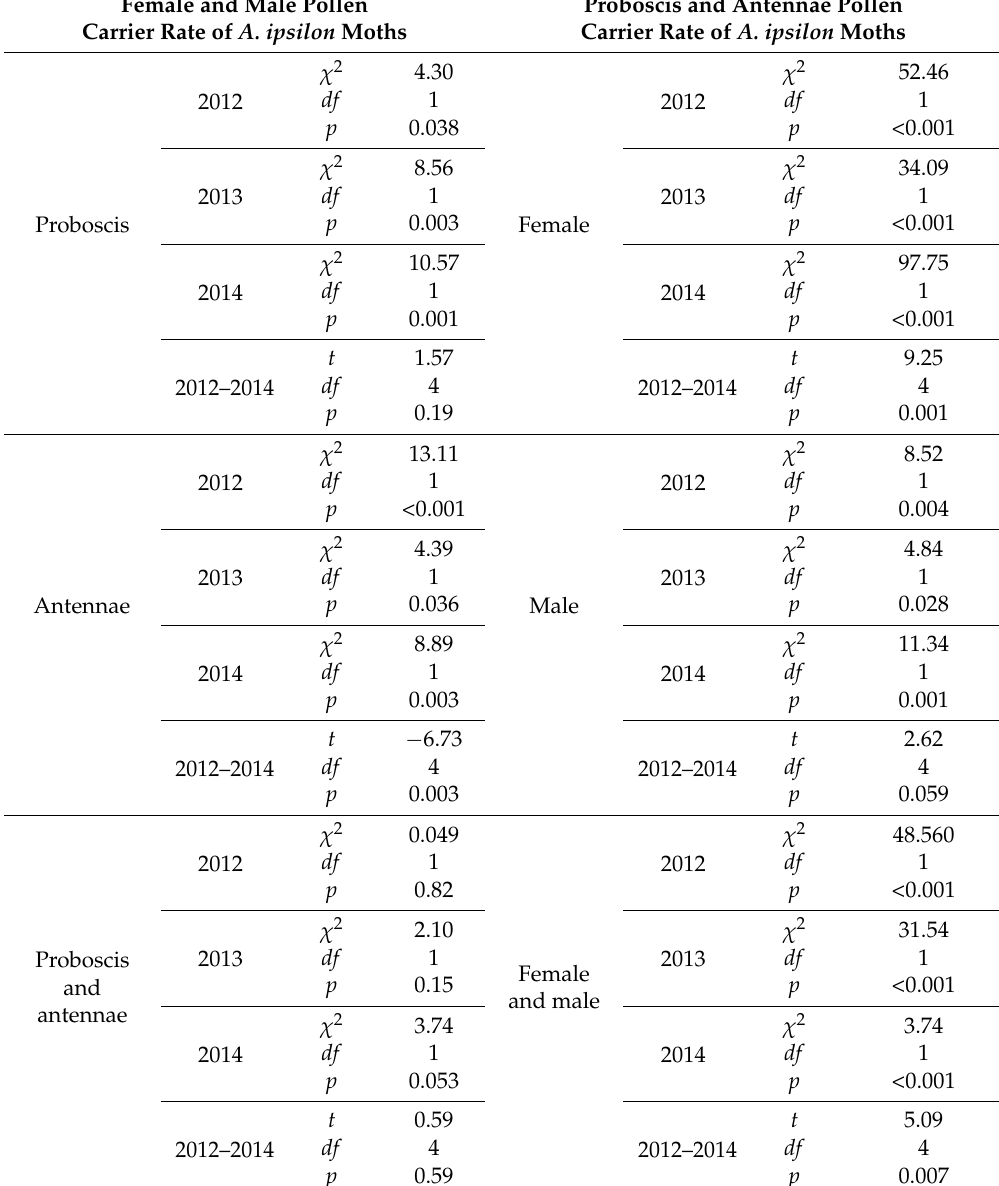
Table 2. Chi-squared test and a Student’s t -test for tested frequencies of pollen deposition on A.